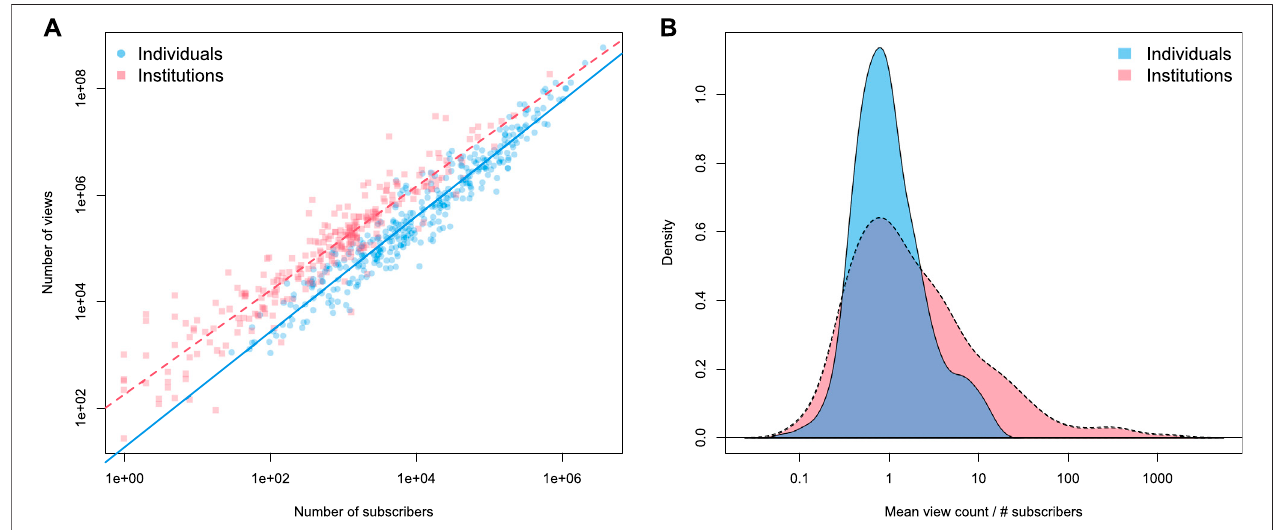
FIGURE 7 | Relationship between views and subscribers. (A) Relationship between number of views across all videos and number of subscribers (log10), (B) Distribution of mean view number by video normalized by the number of subscribers of the channel.